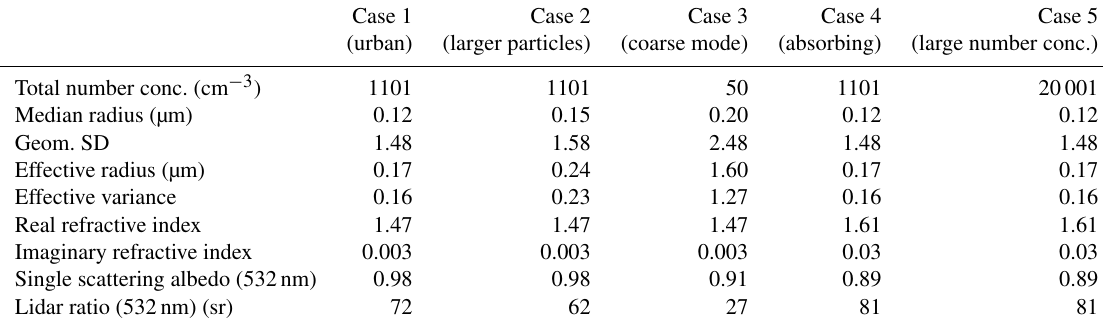
Table 1. State variables and selected derived variables for five constructed reference